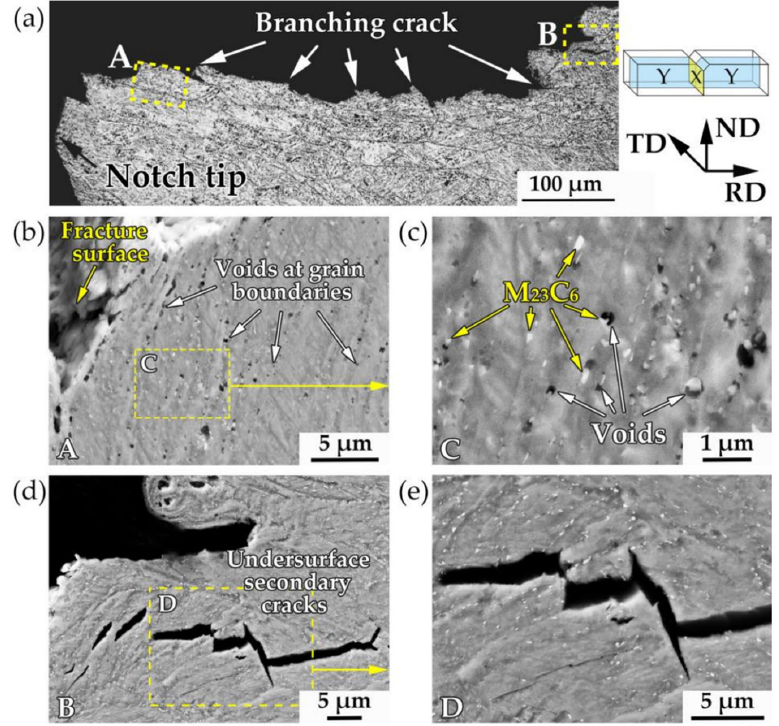
Figure 15. OM ( a ) and SEM ( b – e ) images of side surface of impact sample after HTMT, which frac ‐ tured at Т = − 25 ℃ . The magnified images of the areas A–D outlined by dashed frames are repre ‐ sented in ( b – e ), respectively. Х —fracture plane (yellow), Y—plane under investigation (light blue).